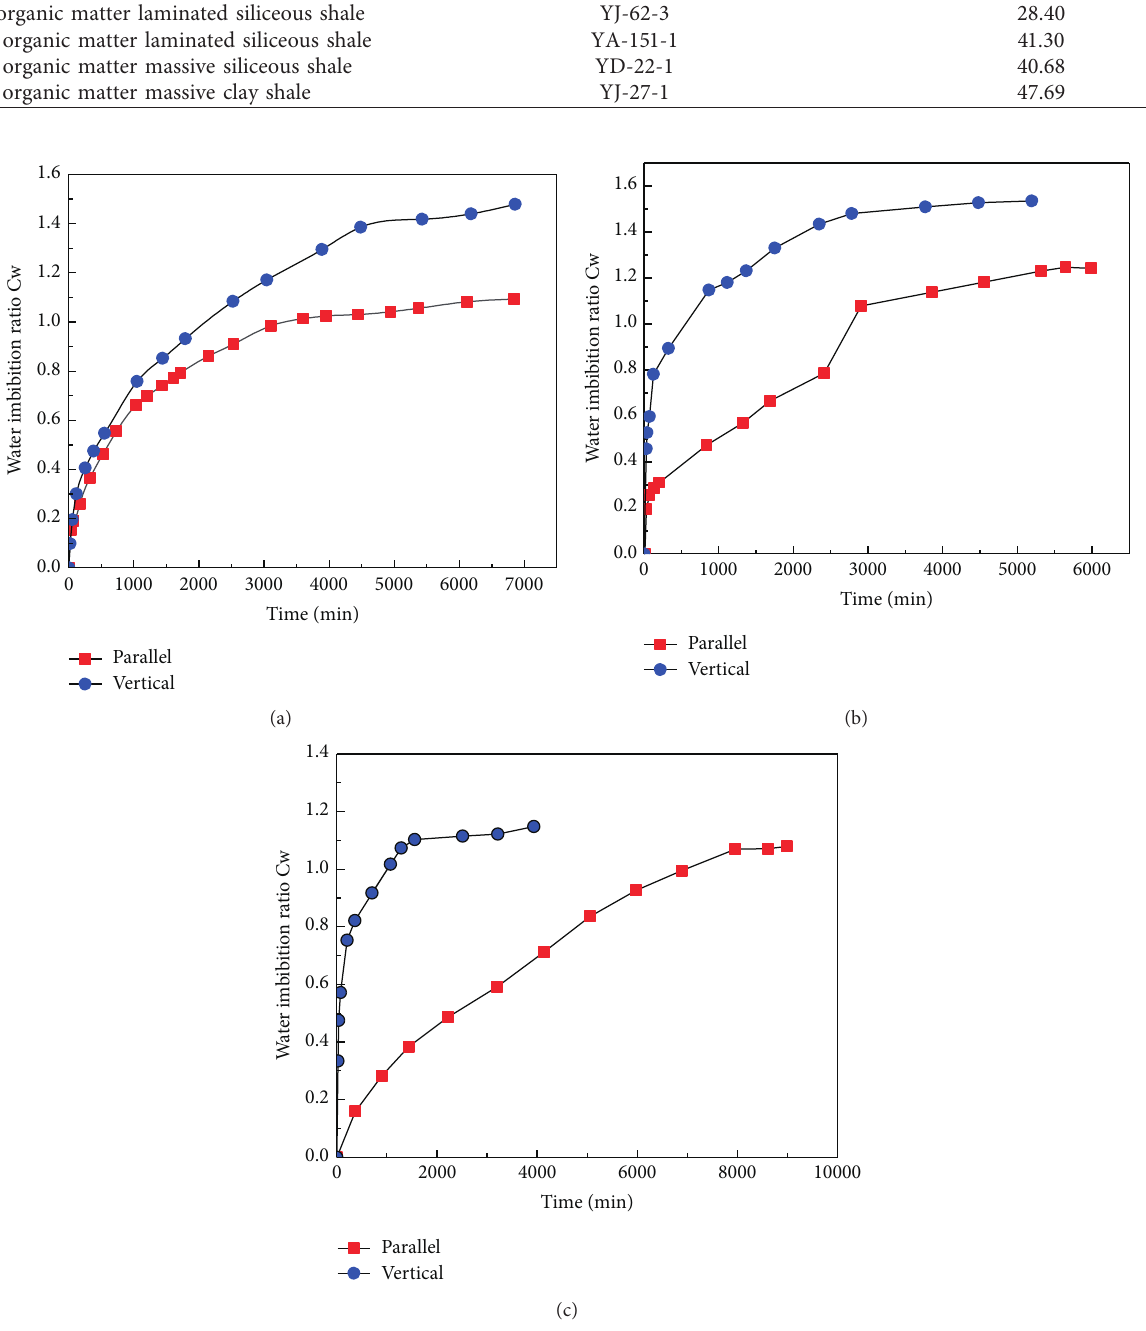
Figure 4: Comparison of water imbibition differences between vertical and parallel bedding directions of different lithofacies. (a) Sandy interlayer YY-72-2. (b) Low organic matter laminated siliceous shale YJ-62-3. (c) High organic matter laminated siliceous shale